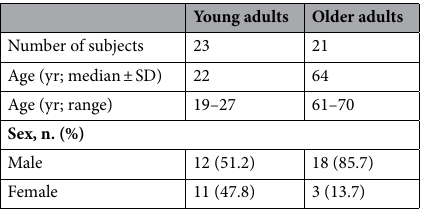
Table 1. Demographic characteristics of the study